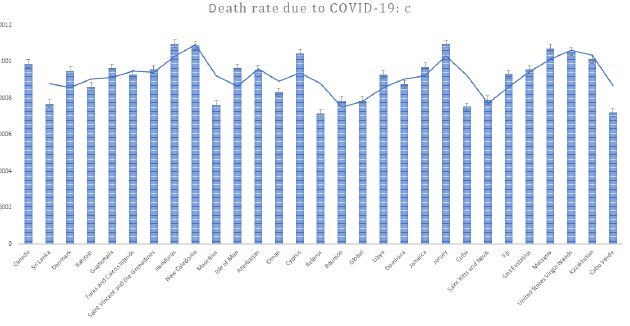
Figure 2. COVID-19 mortality rates of 29